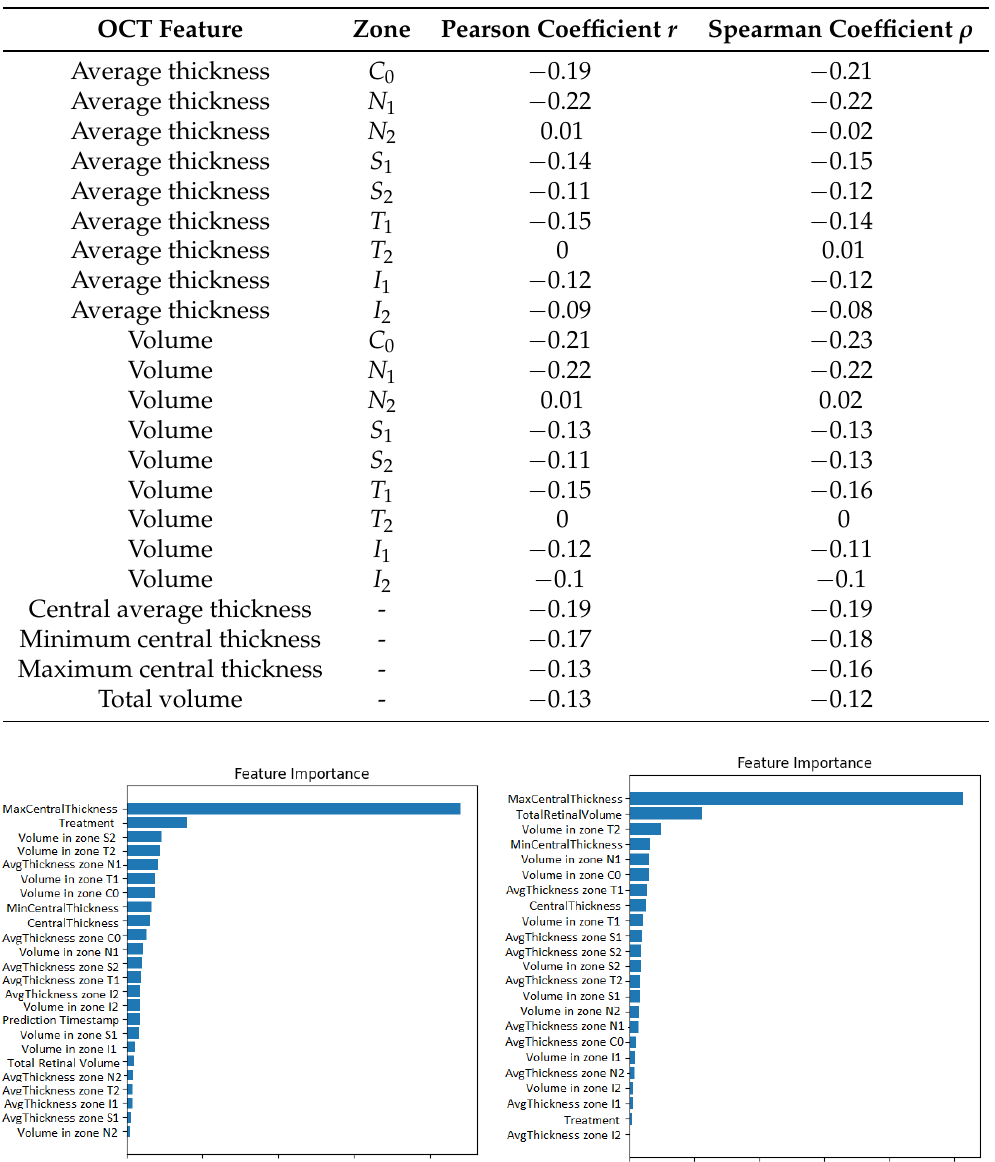
Table 1. Univariate correlation of OCT features with visual acuity.